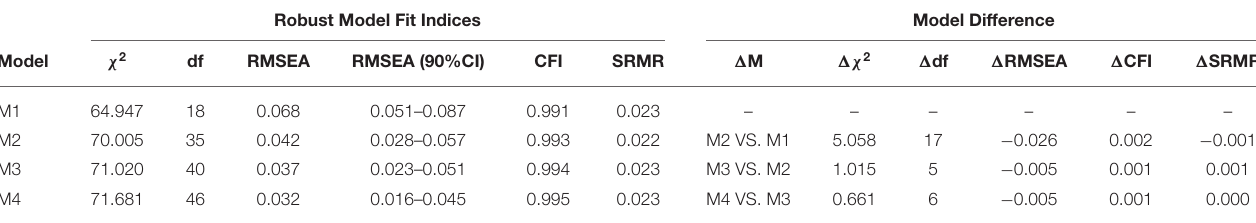
TABLE 3 | Fit indices for measurement invariance